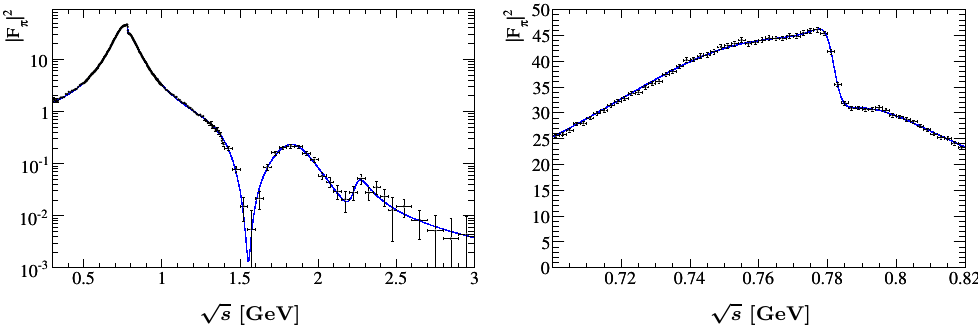
2 . Left: (cid:12)t to the BaBaR data [87] using the vector- F (cid:25) j j